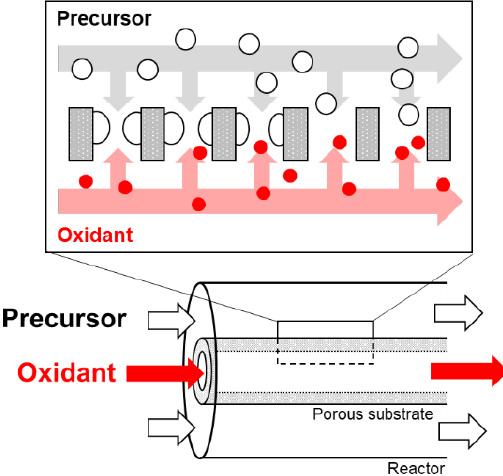
ff usion chemical vapor di ff usion Figure 2. Counter diffusion chemical vapor diffusion method. Figure 2. Counter di